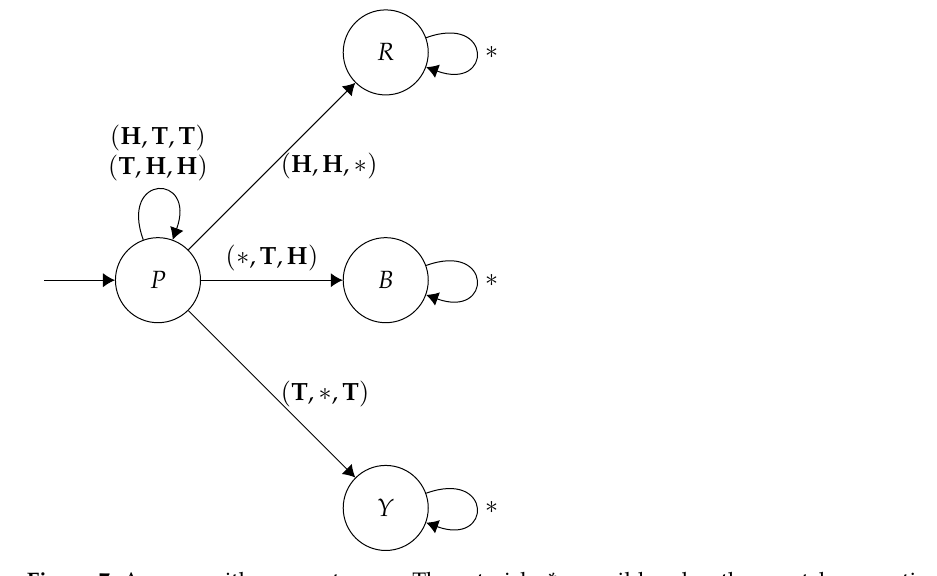
Figure 7. A game with an empty core. The asterisks * are wildcards—they match any action which isn’t explicitly detailed on the